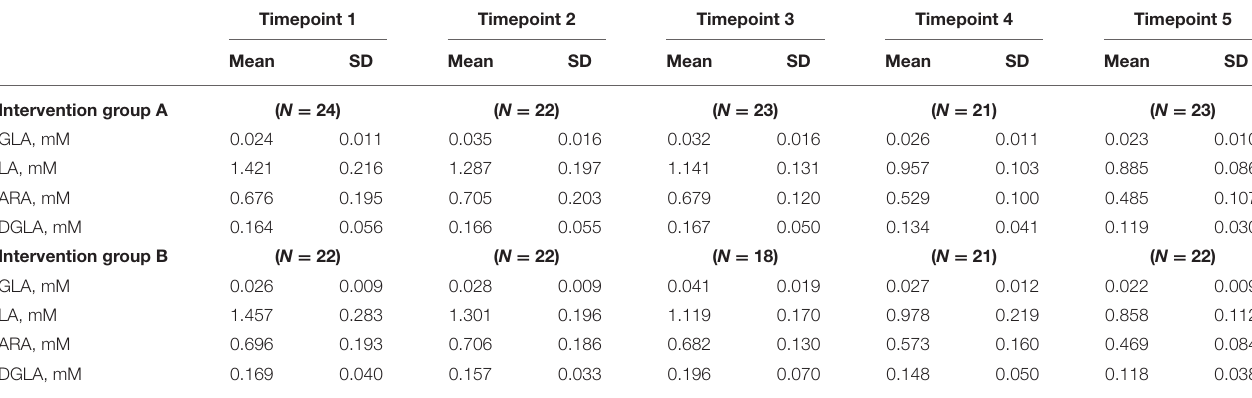
TABLE 6 | Plasma essential fatty acid concentrations at all timepoints ¶